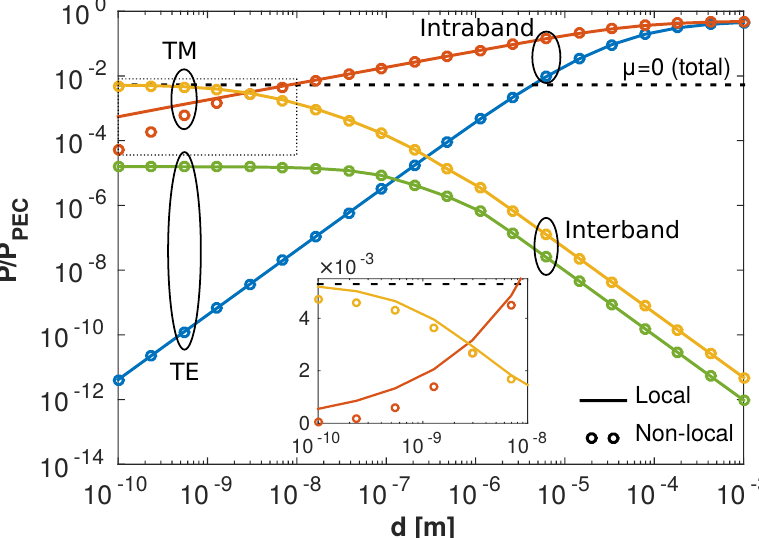
Figure 4. Contributions to the Casimir forces between two graphene sheets ( µ = 0.5eV) as a function of the distance and normalised to the pressure between two perfect conductors P PEC . Full lines represent the local case, whereas the circles denote the local situation. The dashed black line is the total force between intrinsic graphene sheets, P / P PEC ∼ 0.00538. The inset shows the region in the dashed box, where the difference between the local and non-local cases is